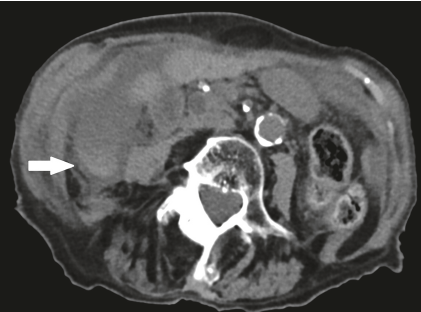
Figure 2: Abdominal unenhanced CT scan: high attenuation area, suggesting an intraluminal hemorrhage.